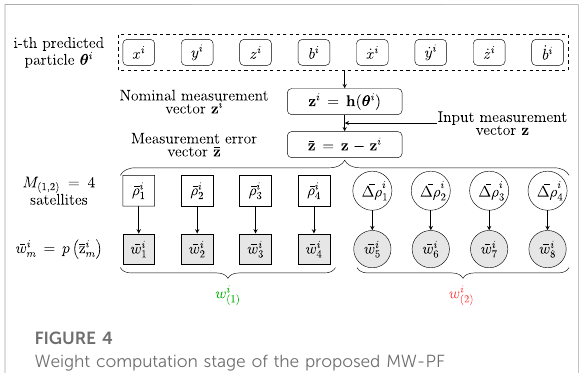
FIGURE 4 Weight computation stage of the proposed MW-PF architecture,basedontwosubsetsofobservablesaccordingto(7).